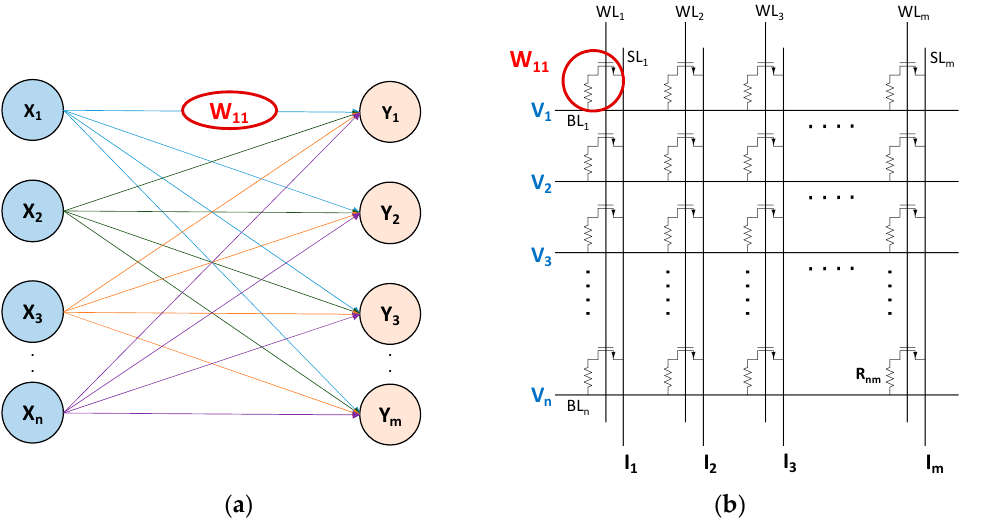
Figure 2. ( a ) Two-layer feed-forward neural network; ( b ) matrix–vector multiplication in a 1T-1R OxRAM array.